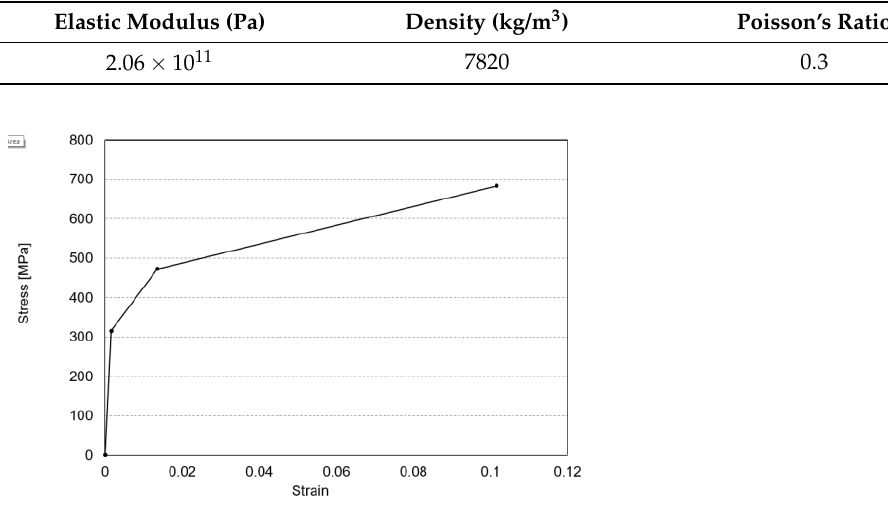
Table 1. Material properties for steel plate.